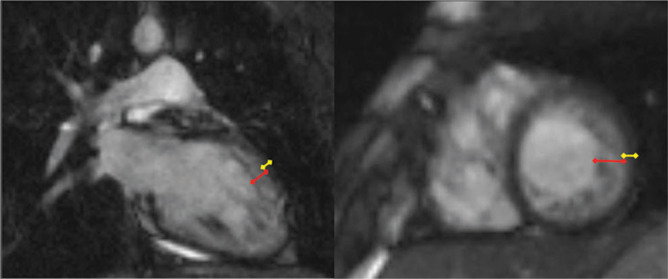
Cardiac MRI images of a patient with IVNC, demonstrating NC:C ratio of 3.7:1 (diagnostic 2.3:1).